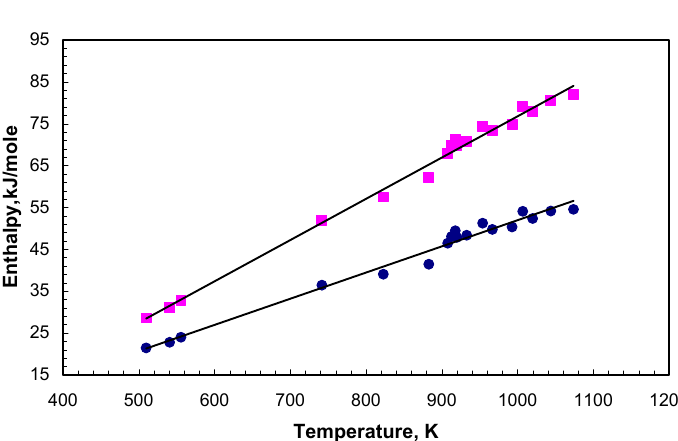
Figure 7. Enthalpy of salts and mixtures before (navy) and after melting (magenta).